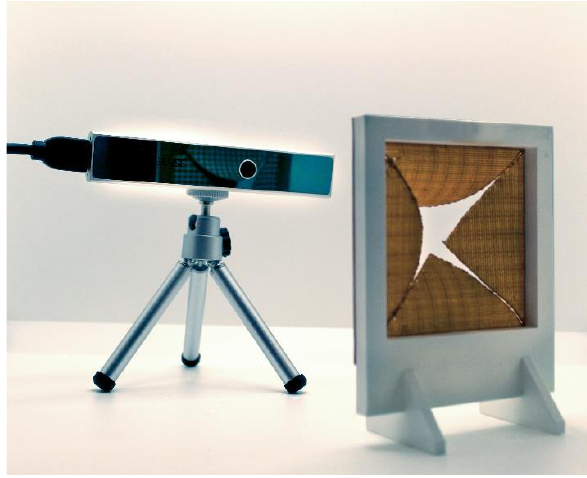
Figure 2 . The RealSense SR305 Depth Camera was put in front of the actuator to acquire its passive